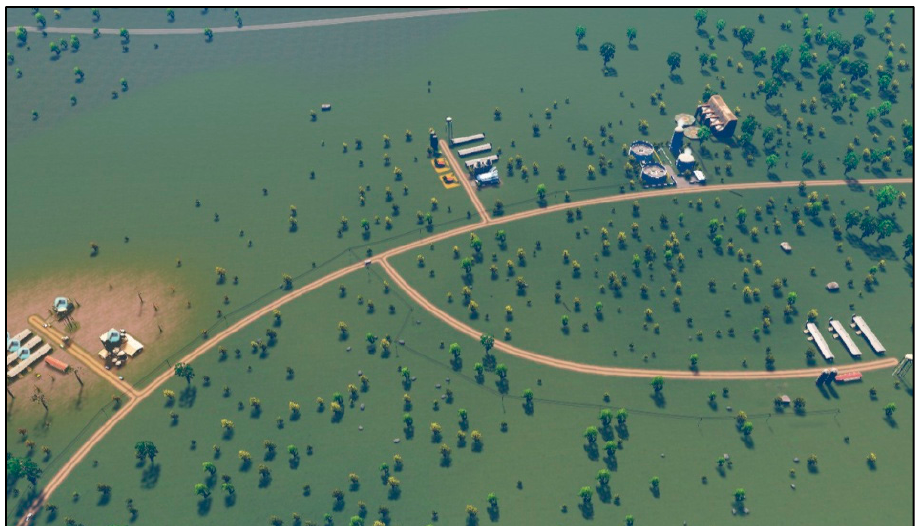
Figure 10. A medium-sized biogas plant located in the village.